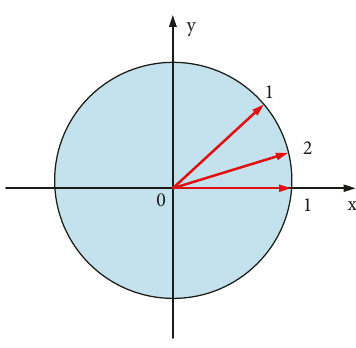
Figure 3: Contour of